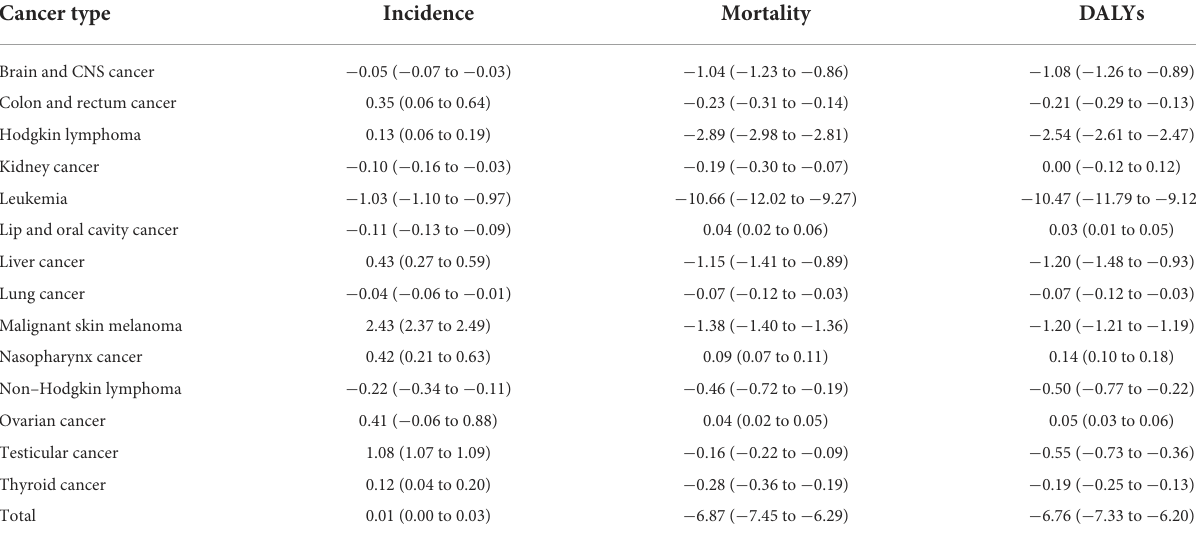
TABLE 1 Average annual percentage change (AAPC) in the 10-year prediction of incidence, mortality, and DALY rates in all the childhood cancers. Cancer type Incidence Mortality